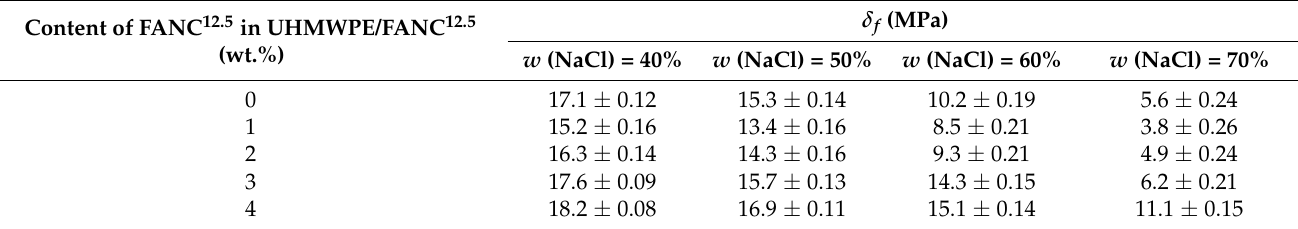
Table 1. Tensile strength values ( δ f ) of porous UHMWPE/FANC 12.5.